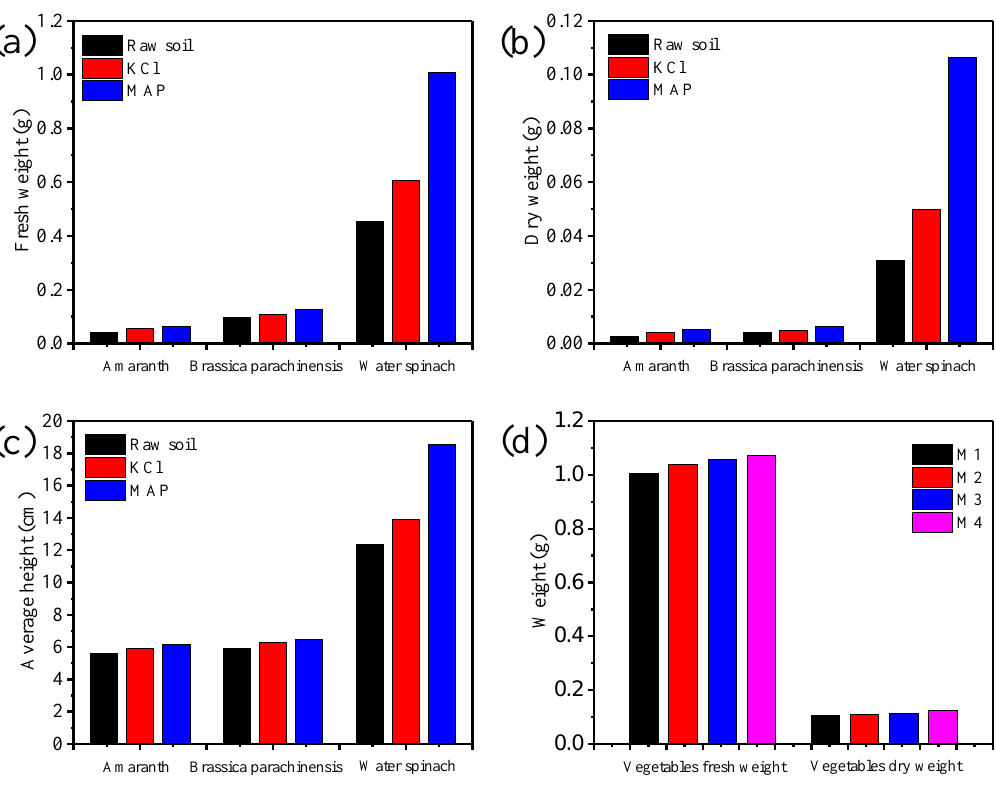
Figure 5. Fresh weight ( a ), dry weight ( b ) and average height ( c ) of vegetables after 35 days growth. Fresh weight and dry weight of four individual swamp cabbages with different MAP dose ( d ).